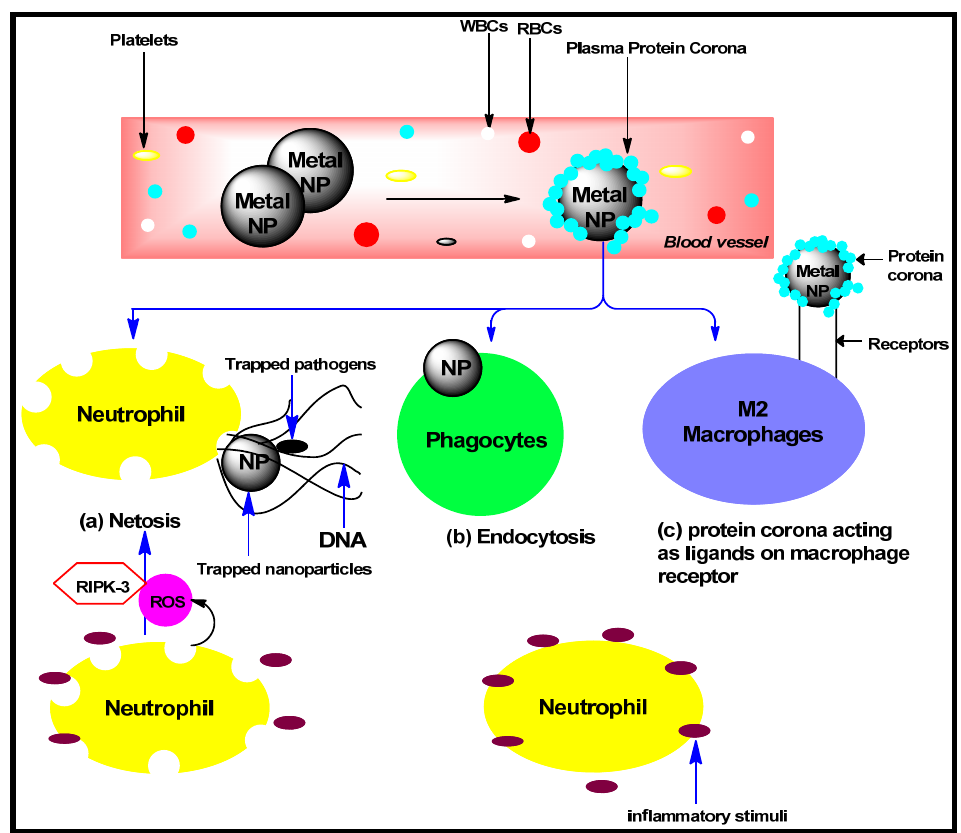
Figure 8. The anti ‐ inflammatory mechanism adopted by metal ‐ based nanoparticles. Redrawn Figure 8. The anti-inflammatory mechanism adopted by metal-based nanoparticles. Redrawn from [187], from [187] , with permission from Elsevier (copyright 2022). with permission from Elsevier (copyright